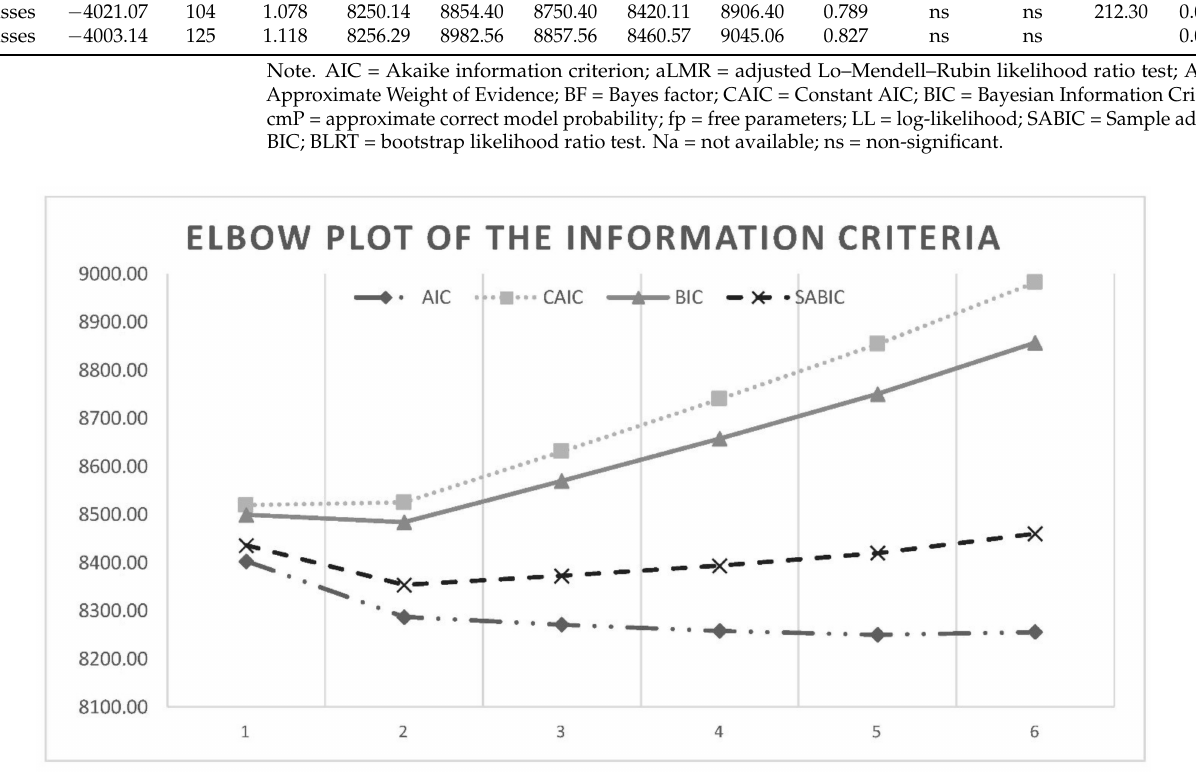
Figure 1. Elbow plot of the information